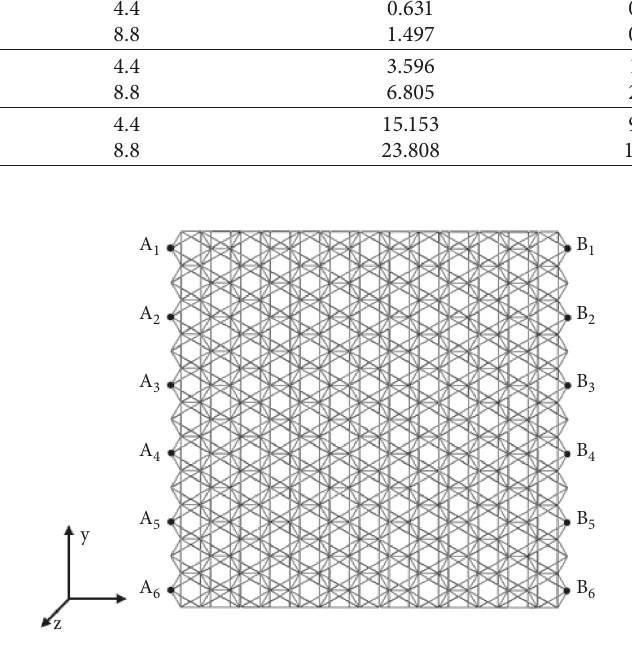
Figure 13: Schematic diagram of node selection.